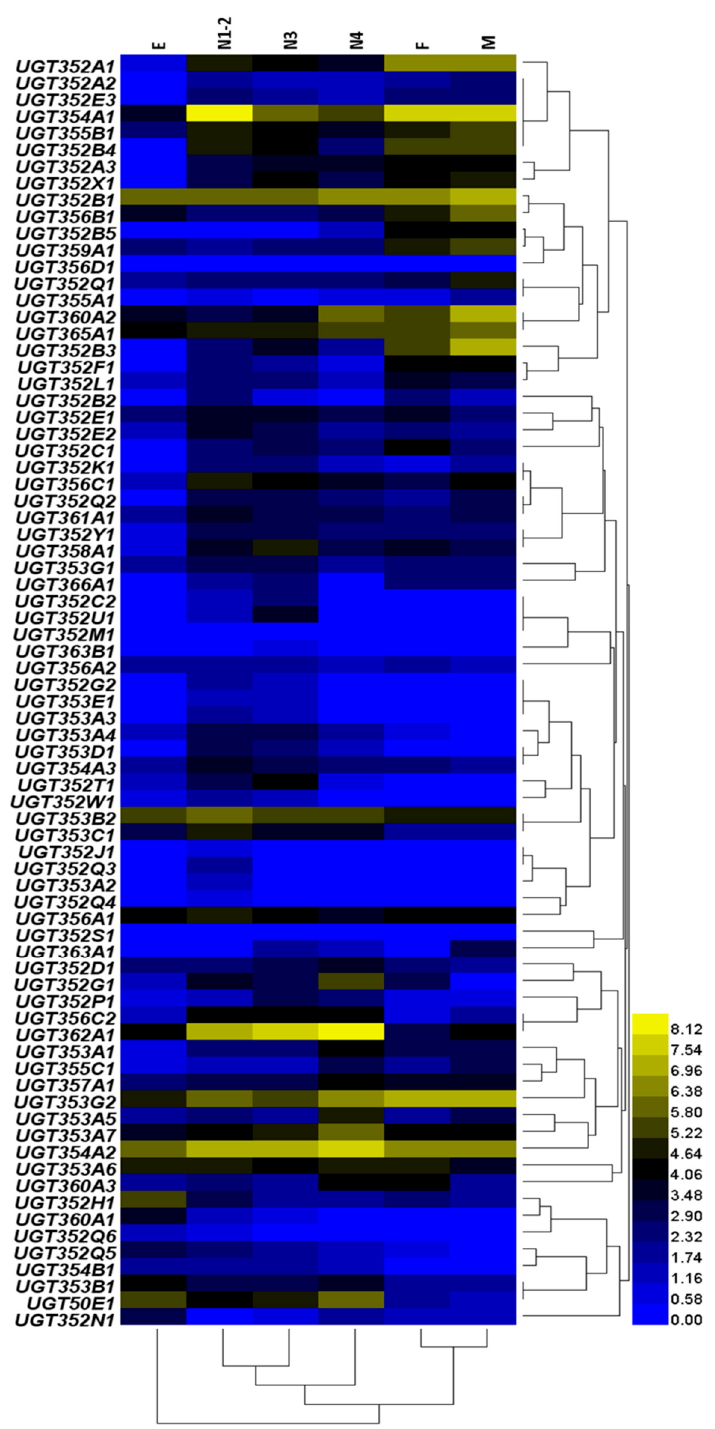
Figure 5. Gene expressions of UGTs across different developmental stages from MEAM1. The codes on the left are the gene ID numbers of the 76 UGTs in B. tabaci MEAM1. The mRNA levels, as represented by log2 (TPM + 1) values, are shown in the gradient heat map with colors ranging from blue (low expression) to yellow (high expression). E, egg; N1-2, 1st- and 2nd- instar nymphs; N3, 3rd- instar nymphs; N4, 4th- instar nymphs; F, adult female; M, adult male.